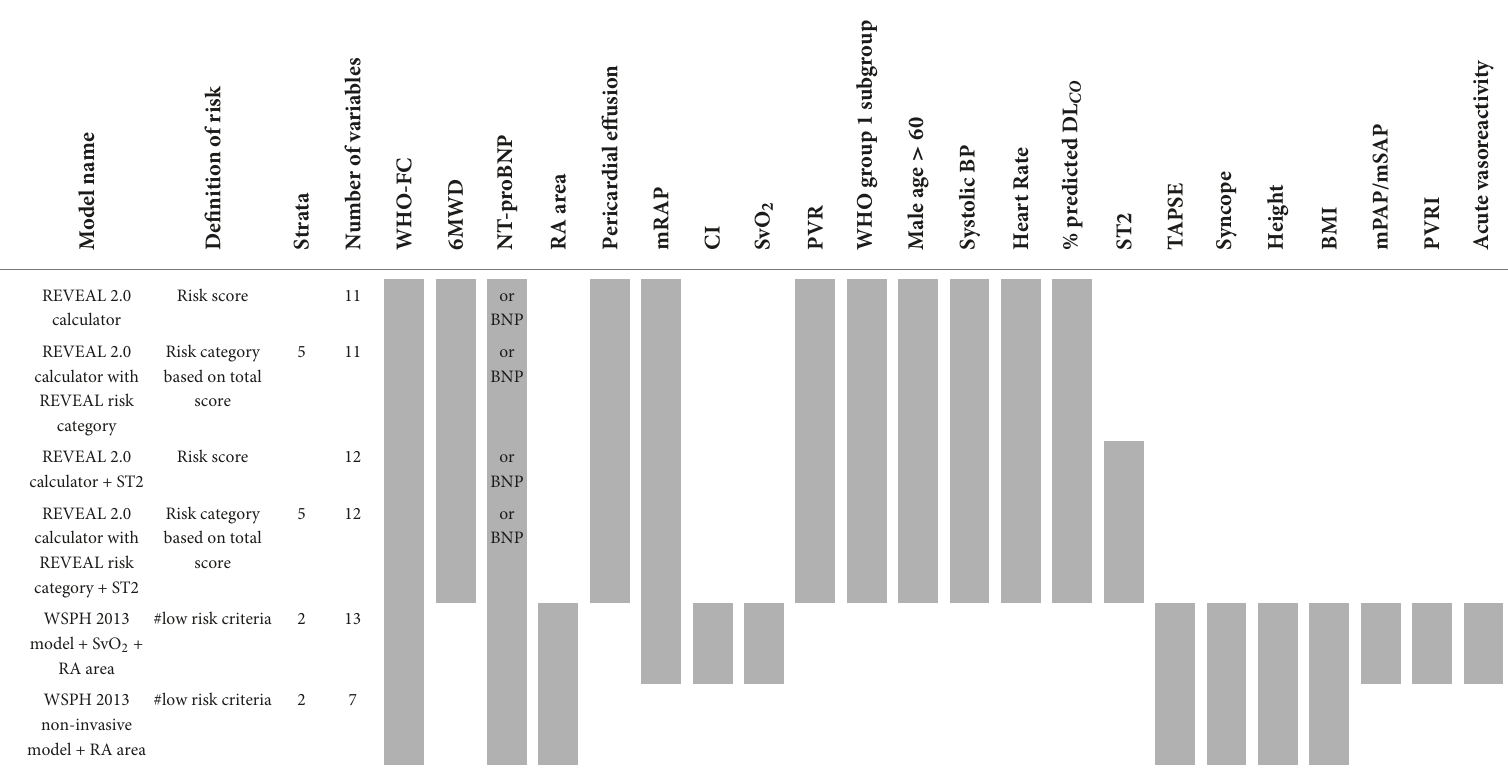
TABLE 7 Variables used in pediatric risk stratification